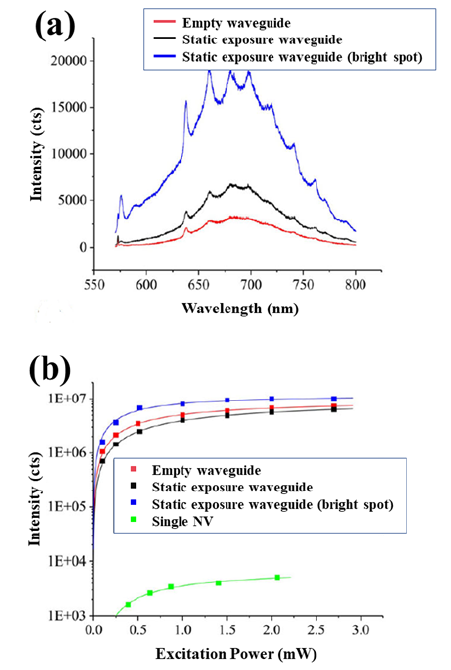
Fig. 2. PL spectra (a) and Power dependent PL (b ) from ‘empty’ waveguide, ‘static exposure’ waveguide and from a bright spot (static